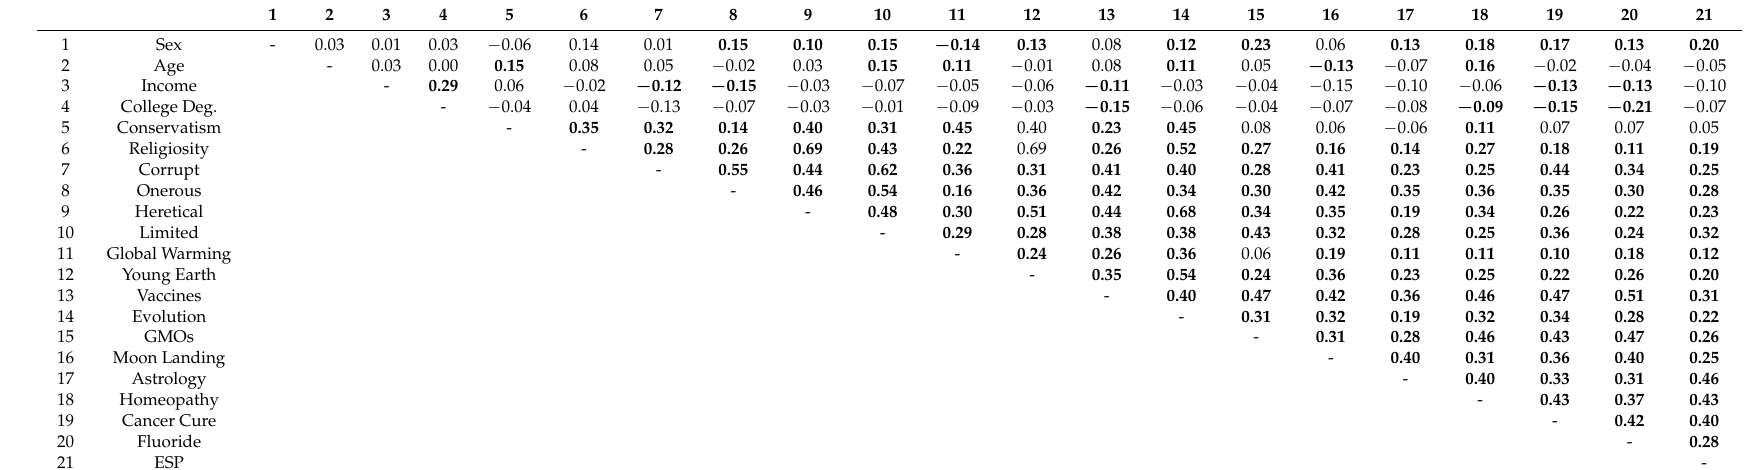
Table 5. Correlations among All Study